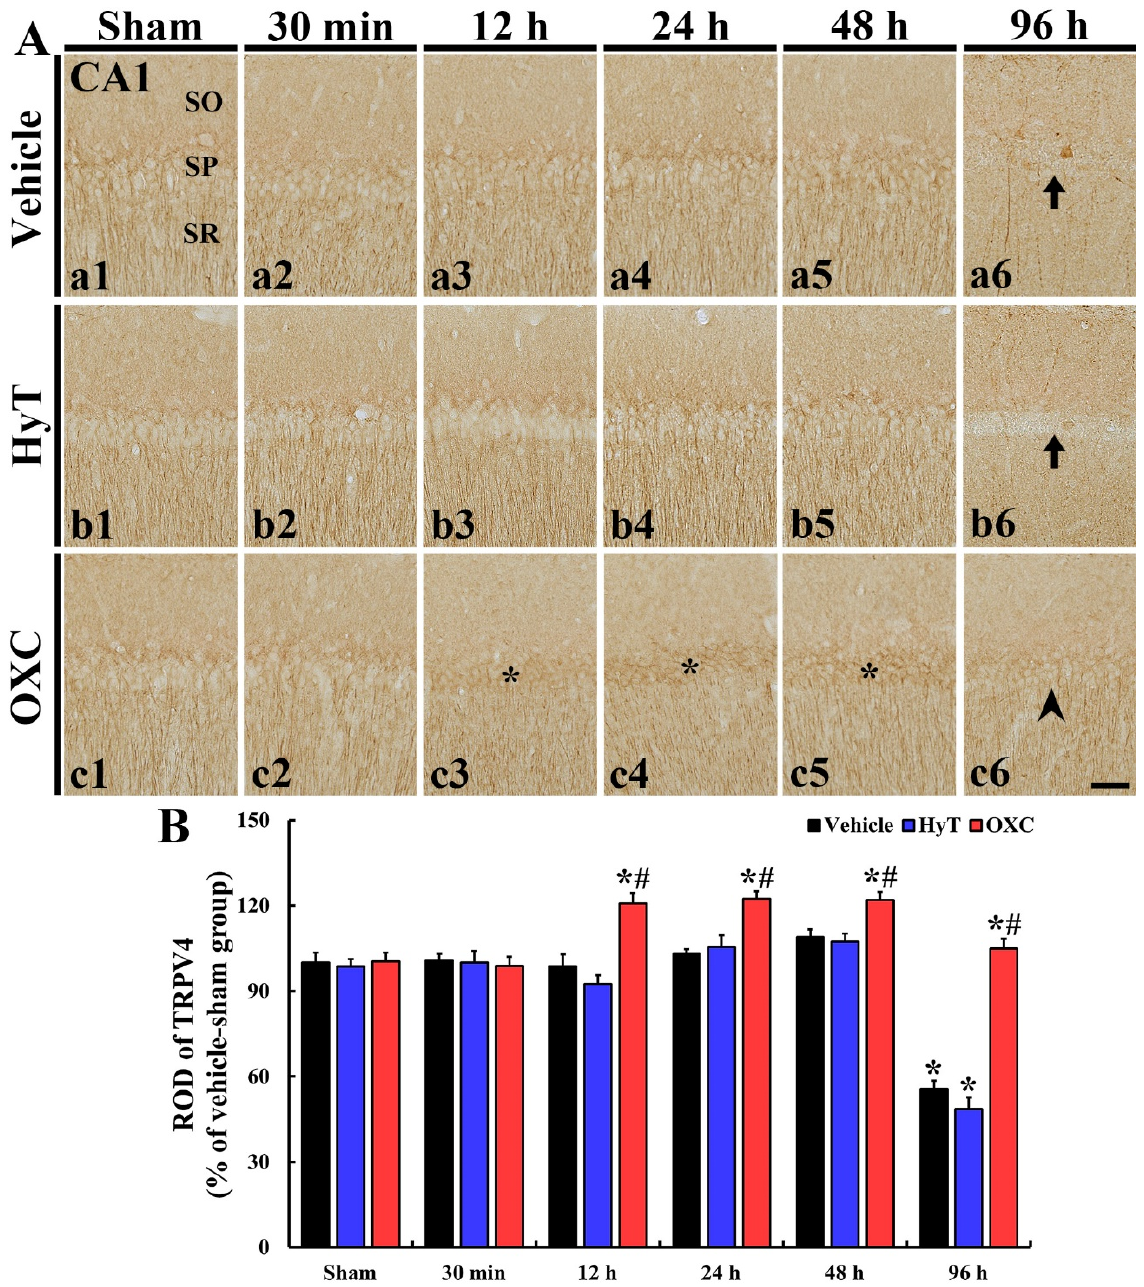
Figure 6. ( A ) Representative images of TRPV4 immunohistochemistry in the CA1 region of all groups at 30 min, 12 h, 1 day, 2 days, and 4 days after tFI or sham operation. In the tFI+vehicle and tFI+HyT groups, TRPV4 immunoreactivity was similar to that in the sham+vehicle group until 2 days after tFI, but it was dramatically reduced in the SP (arrows) at four days after tFI. In contrast, TRPV4 immunoreactivity of the tFI+OXC group was significantly increased (asterisks) in the SP at 12 h after tFI and slightly decreased (arrowhead) at four days after tFI. ( B ) ROD of TRPV4 immunoreactivity. The bars indicate the means ± SEM ( n = 7 for each group; * p < 0.05 vs. sham+vehicle group, # p < 0.05 vs. corresponding time of the tFI+vehicle group). SO, stratum oriens; SR, stratum radiatum. Scale bars = 100 µ